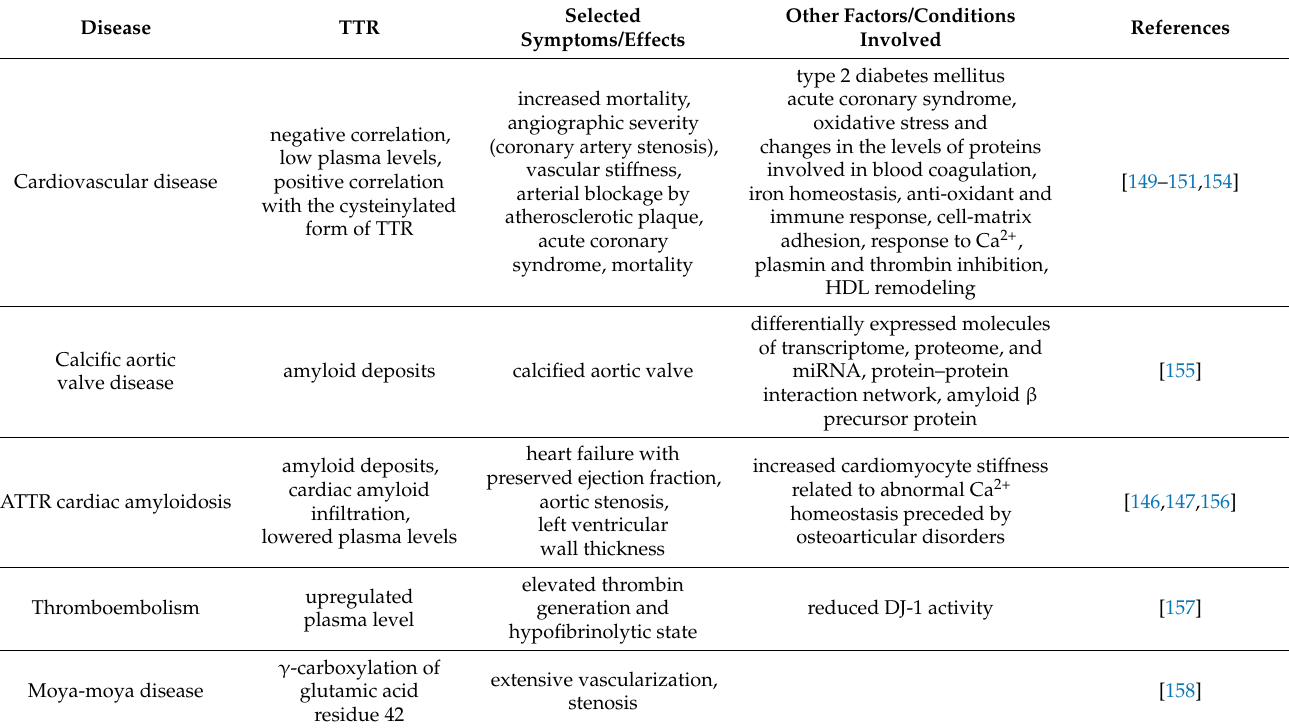
Table 2. Vascular diseases involving